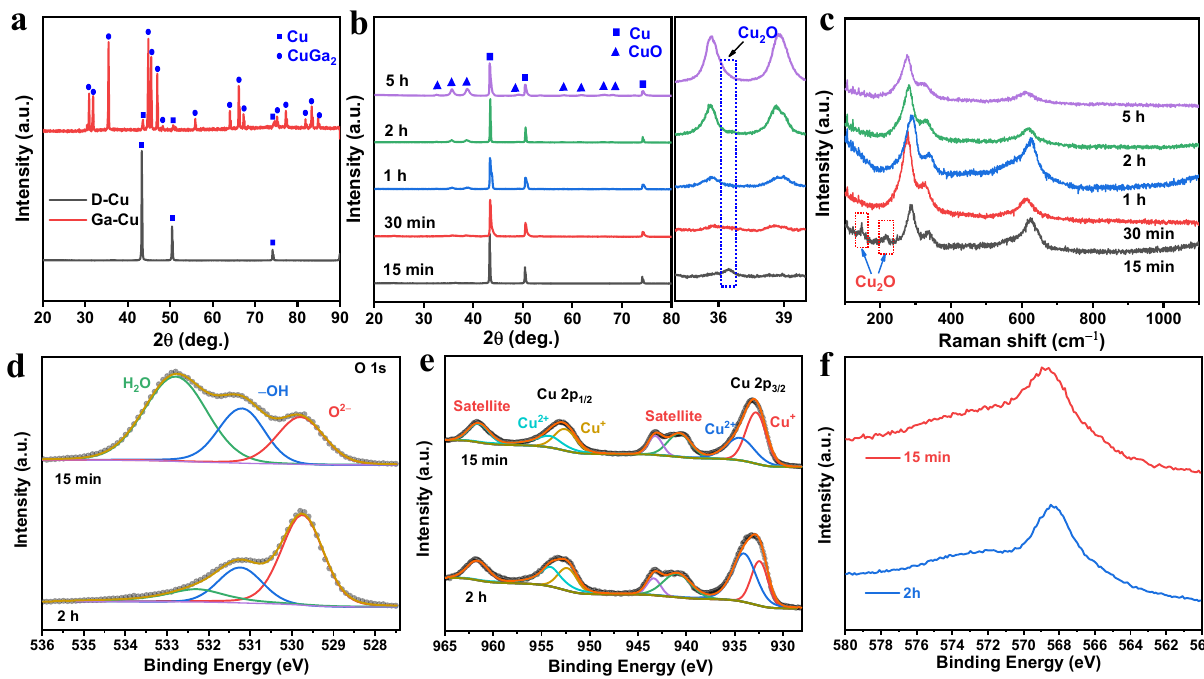
Figure 2. XRD patterns of ( a ) annealed Ga-Cu before and after dealloying and ( b ) dealloyed Cu film after being electro-oxidized for a different time; ( c ) Raman spectra; ( d – f ) XPS spectra of O 1s, Cu 2p, and Cu LMM for O-Cu-15m and O-Cu-2h.